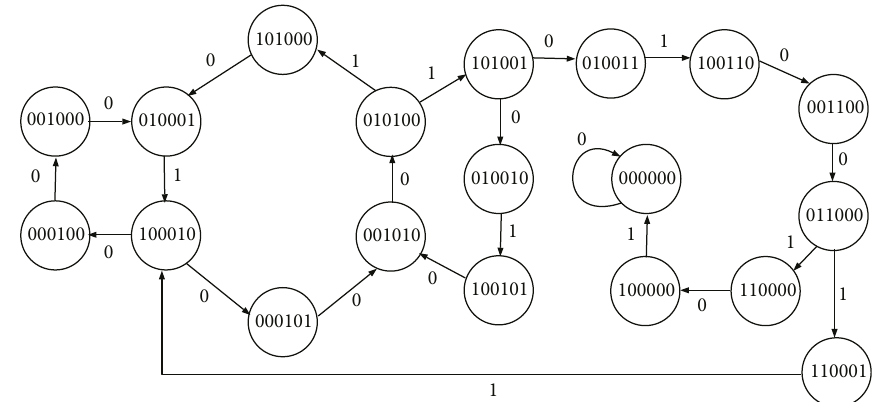
Figure 10: Some paths of the De Bruijn diagram showing the states determined for the evolution rule.